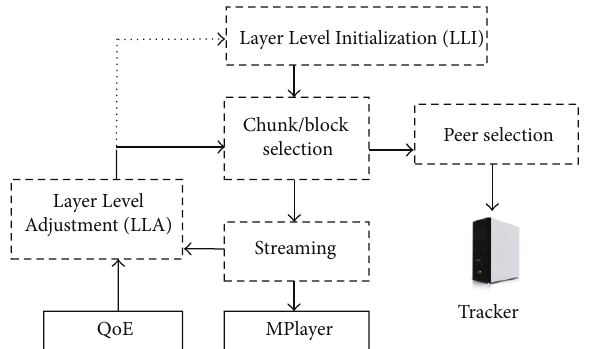
Figure 1: The quality adaptive P2PTV